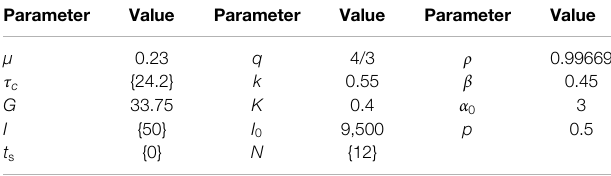
TABLE 1 | Default parameter values used in analysis and model simulations. Parameter